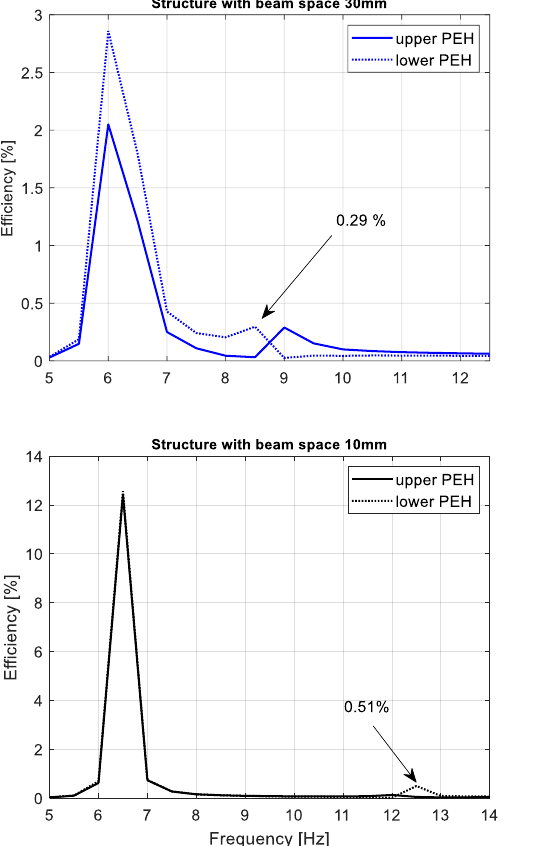
Figure 13. The comparison of the efficiency of real magnetic coupled harvesters by various beam spaces in the